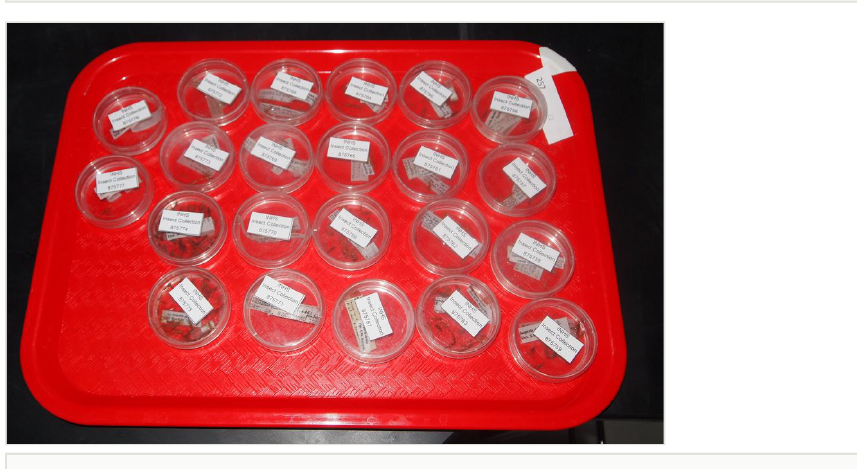
Figure 2. Tray and Plecoptera specimens ready for imaging. Note metadata label in upper right corner detailing rack number and number of vials. White tape in that corner orients placement of dishes by student